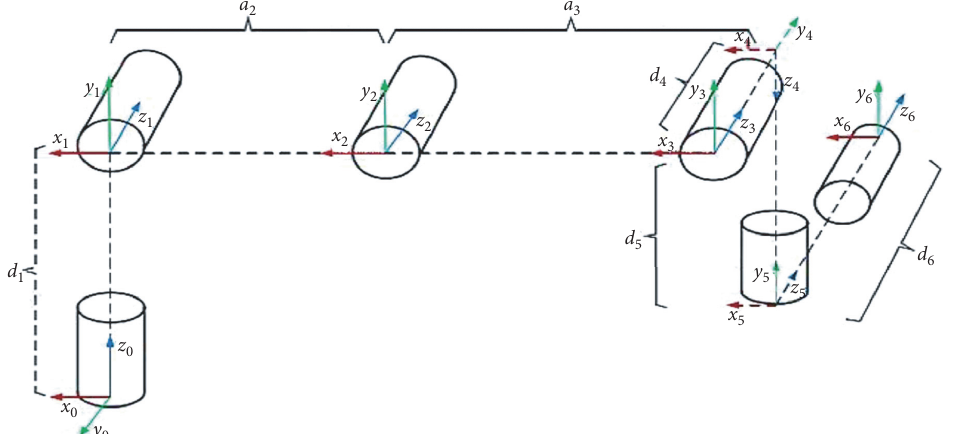
Figure 4: Robot’s dynamic diagram and DH parameter